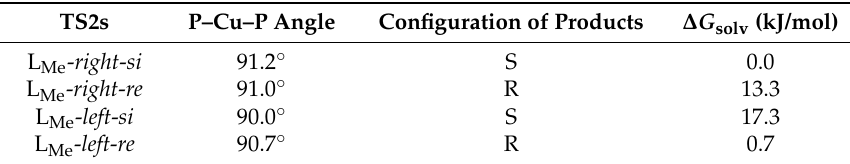
Table 3. ∆ G values of competing TS2 s in the ( S,S )-Me-PBE system.